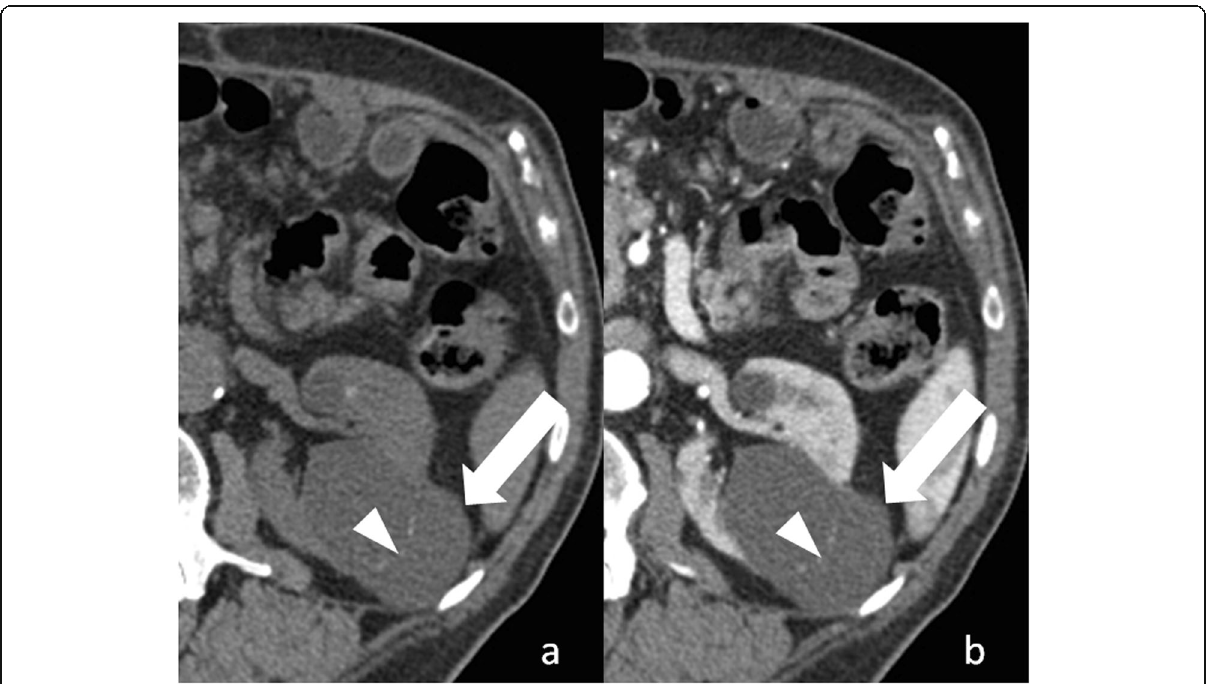
Fig. 5 Bosniak category II renal cyst. a Axial non-enhanced CT image shows a lesion with a thin wall (arrow) and a thin septum (arrowhead), which contains fine calcifications. b Corresponding axial contrast-enhanced CT image shows enhancement of cyst wall and septum